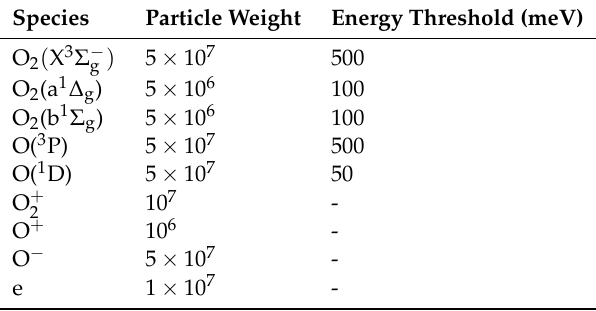
Table 1. The parameters of the simulation, the particle weight, and the energy threshold above which kinetics of the neutral particles are